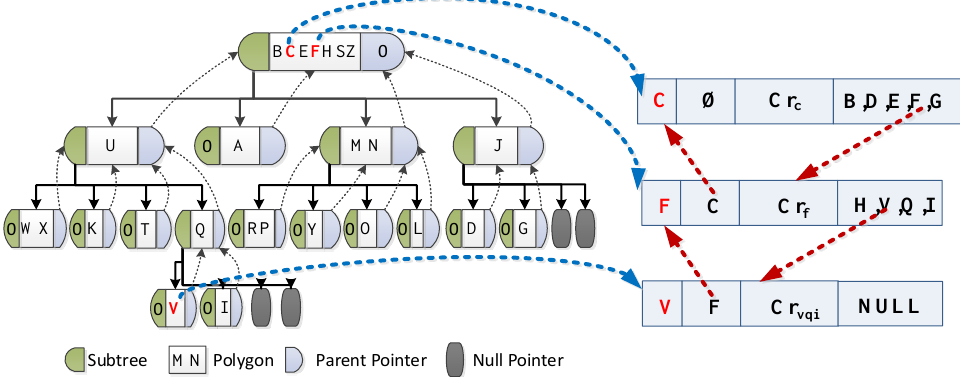
Figure 2. Improved Quadtree Index of Fig.1 (a) and the Nested Inclusion Relations among Polygon C, F, V